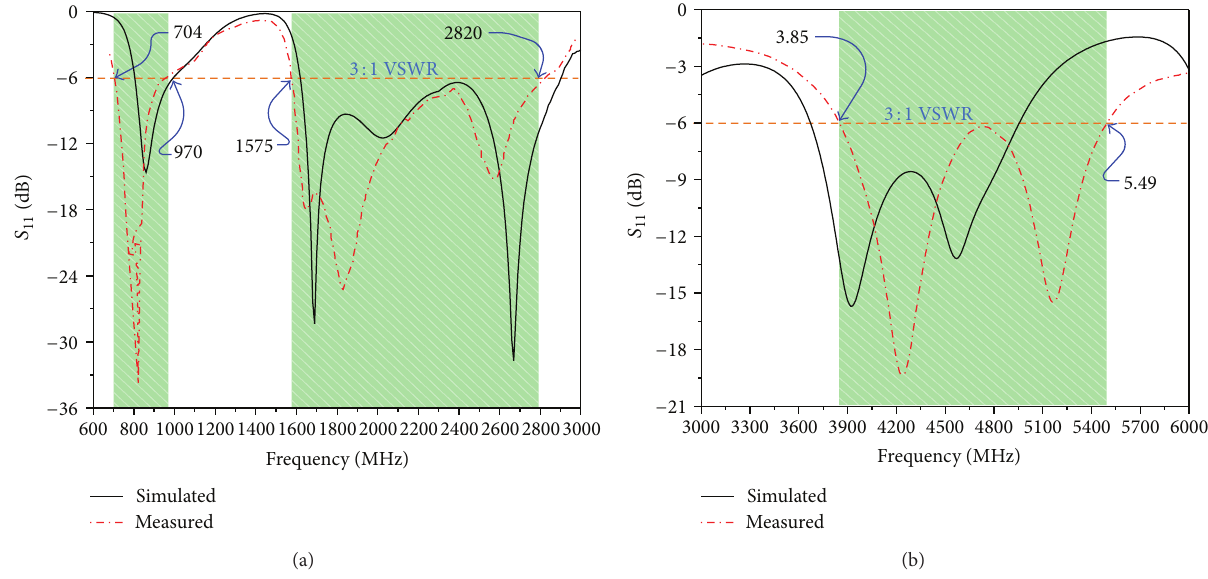
Figure 6: Measured 𝑆 parameter and simulated 𝑆 parameter: (a) 600–3000 MHz and (b) 3000–6000 MHz.